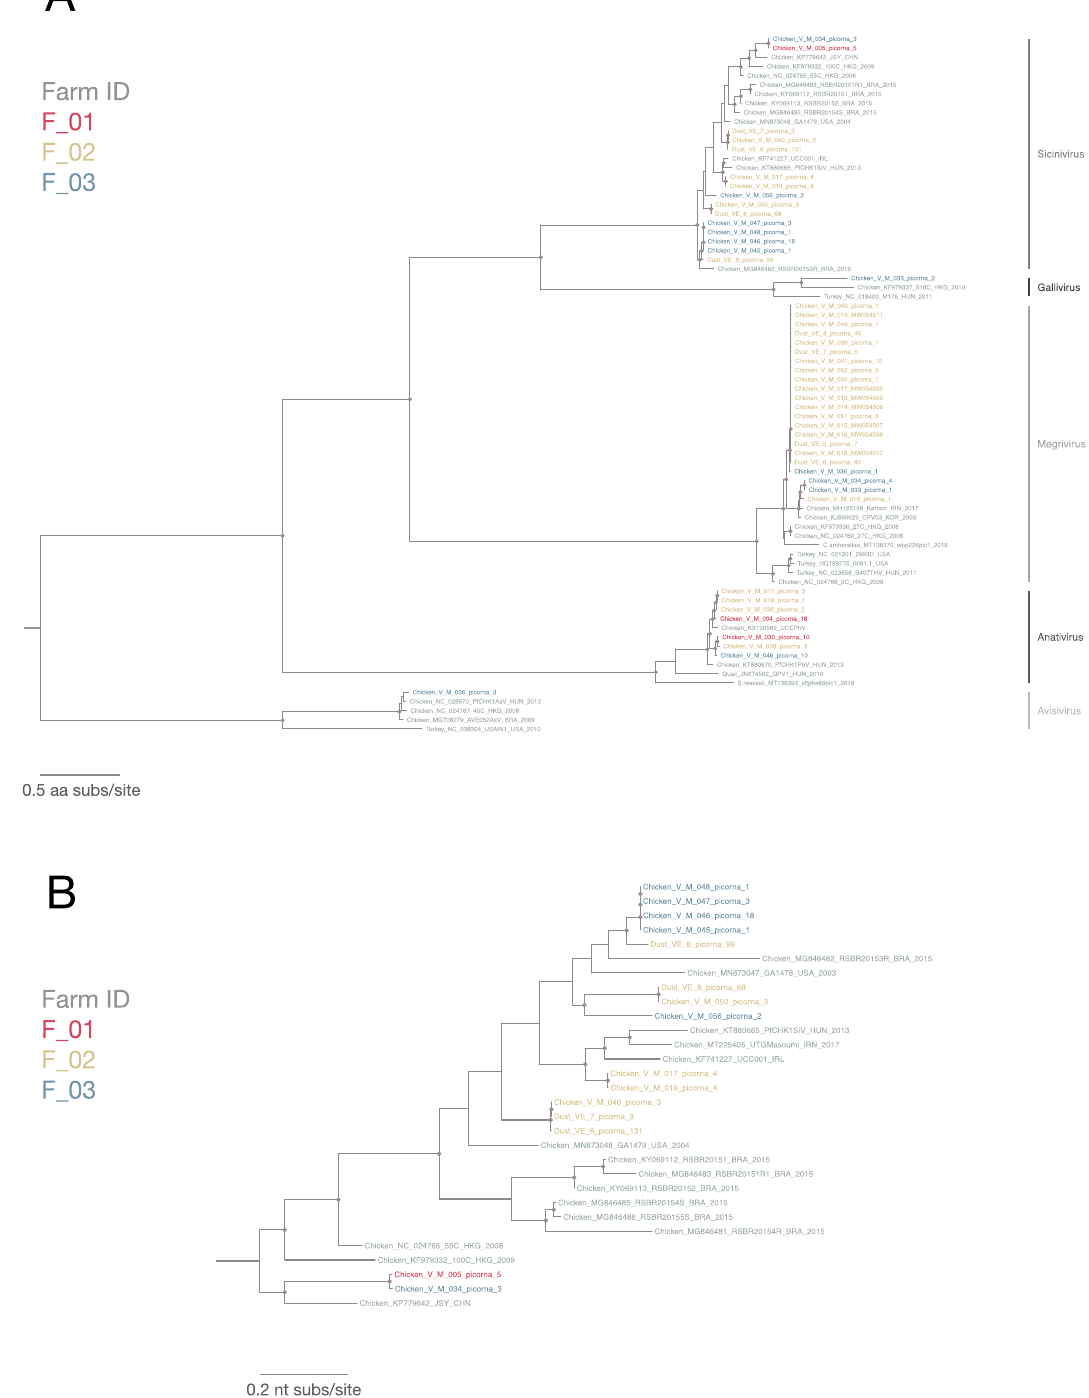
Figure 4. ( A ) Maximum-likelihood phylogenetic tree of 76 (sequences from this study: 46; reference sequences: 30) picornavirus partial polyprotein amino acid sequences (3786 sites) reconstructed using a best-fit evolutionary model LG + FC + R10. For clarity, only bootstrap supports > = 70 are shown as a light brown node point. Tip labels of our samples are color-coded by corresponding farm ID. Reference sequences are in grey. Tree was mid-point rooted for clarity. ( B ) Maximum-likelihood phylogenetic tree of 30 Sicinivirus partial polyprotein nucleotide sequences (sequences from this study: 15; reference sequences: 15; 8672 sites) reconstructed using a best-fit evolutionary model GTR + F + R10. For clarity, only bootstrap supports > = 70 are shown as a light brown node point. Tip labels of our samples are color-coded by corresponding farm ID. Reference sequences are in grey and tree was mid-point rooted for